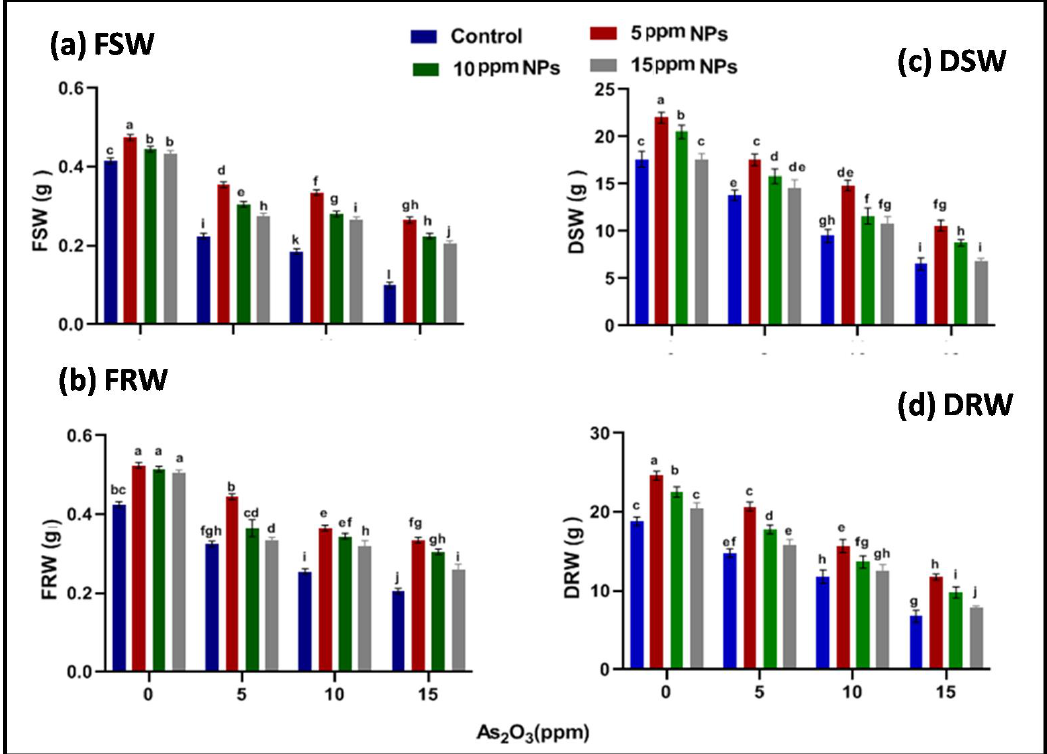
Figure 6. Effect of Bacillus subtilis -synthesized Fe 3 O 4 NPs on ( a ) fresh shoot ( b ) fresh root weight and ( c ) dry shoot ( d ) dry root weight of rice ( Oryza sativa L.) in arsenic-contaminated water. Different letters show a significant difference at p < 0.05 between treatments.